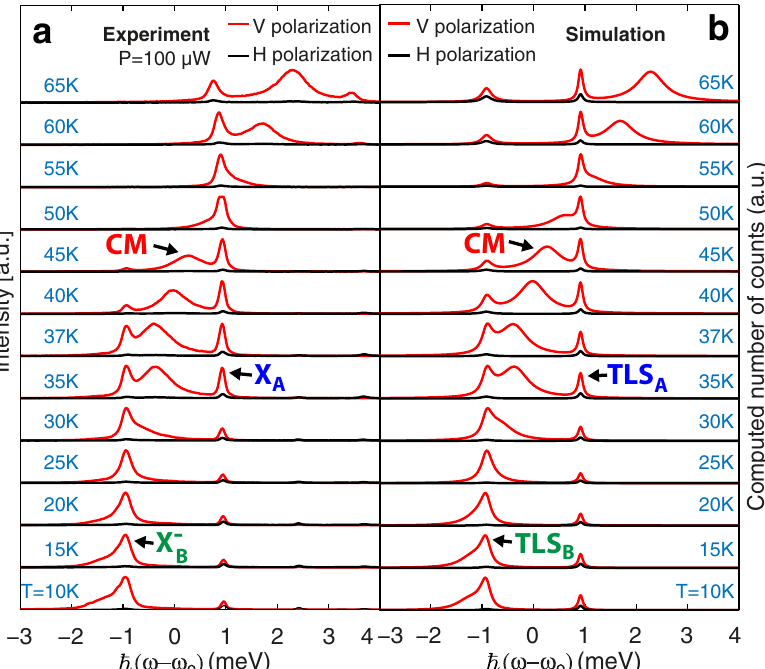
Figure 4. PL spectra of two QDs coupled to the same CM. Comparison of measured ( a ) and calculated ( b ) spectra of the coupled 2QDs-cavity system at different sample temperatures, resolved in linear polarization (see Fig. 1d for definition of V and H polarizations). Spectra are normalized by the maximum intensity and ω ω ω = + − ( . The two-level system (TLS) component is